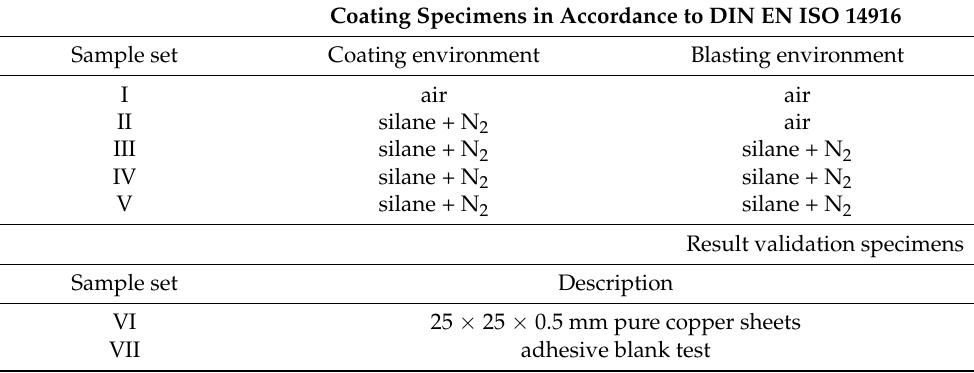
Table 1. Sample set codes of the adhesive tensile strength